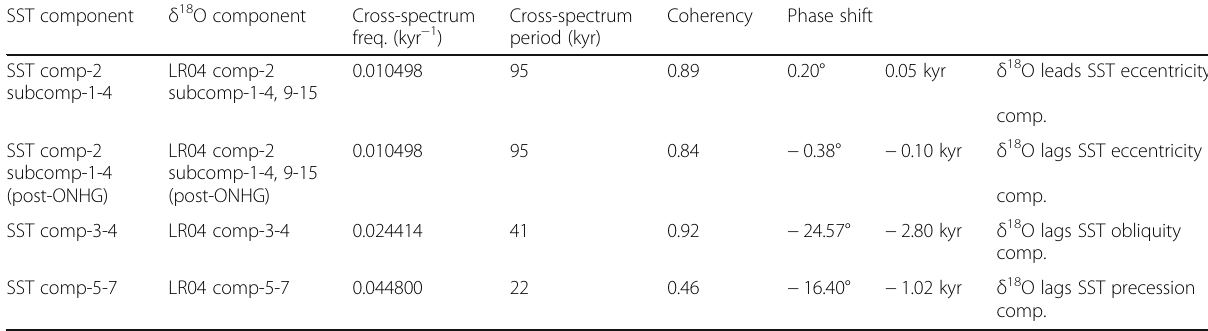
Table 9 Cross-spectral analysis results between orbitally driven δ 18 O and SST components for the last 5 Myr. Data standardized (mean = 0, standard deviation = 1) and, where necessary, inverted to have the same paleoclimatic polarity (positive values for positive forcing and warming) SST